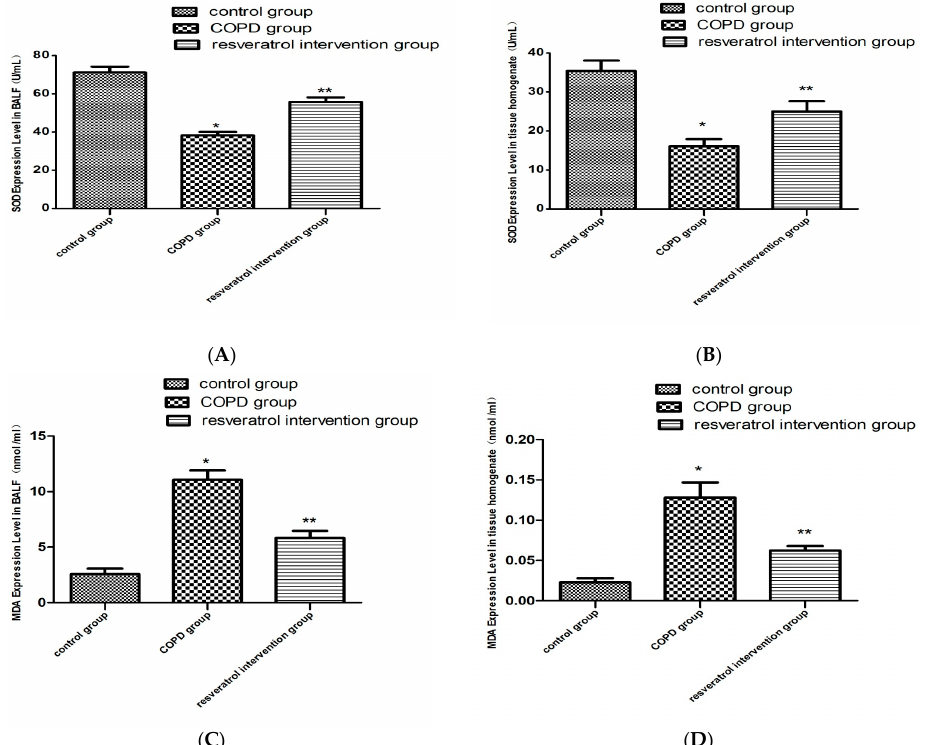
Figure 4. Effects of resveratrol on oxidative stress in COPD rats. SOD and MDA in both BALF and pulmonary tissue omogenate were measured as described in the methods. Resveratrol increases the activity of SOD ( B ) and decreases the concentration of MDA ( D ) in lung tissues of the resveratrol group (n = 10), the same result as in BALF ( A and C ). * p < 0.01, vs. Control group (n = 10); ** p < 0.01, vs. COPD group (n = 10).